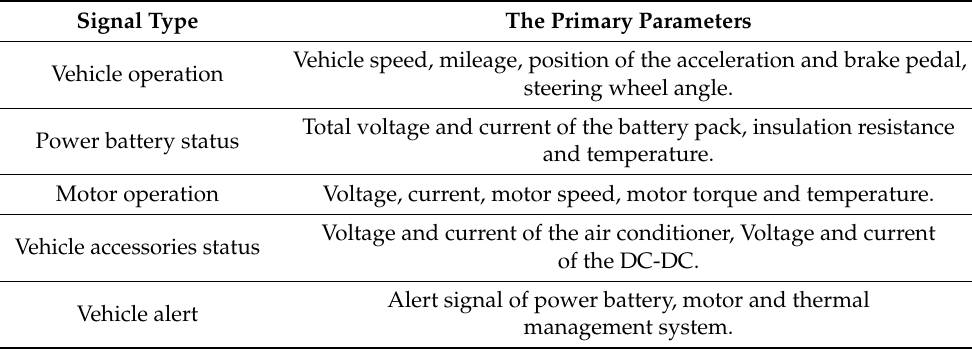
Table 1. The primary parameters collected by the data acquisition system.